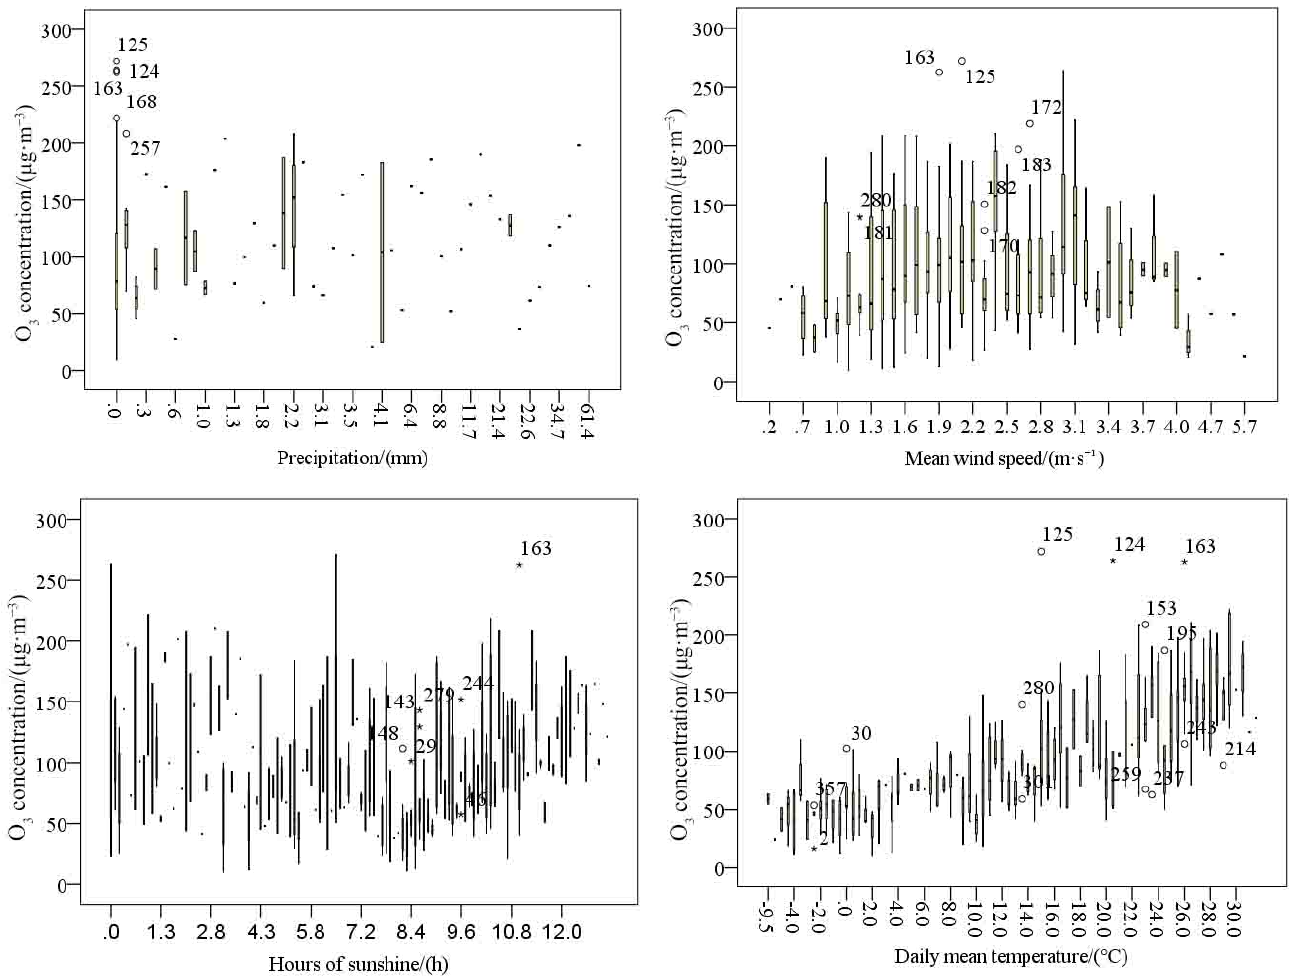
Figure 8. O 3 concentration corresponding to different meteorological factors.